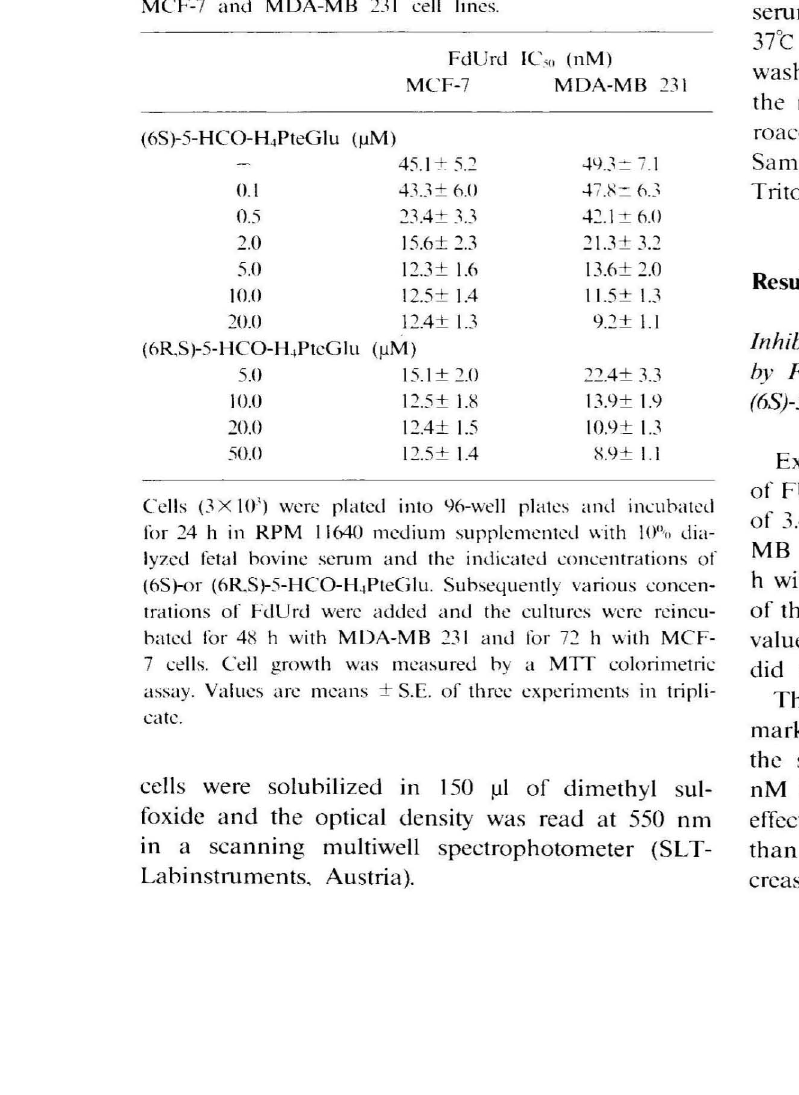
Table 1. Etlcct of increasing concentrations of (6S)- and (6R$)-S-HCO-H4PteGlu on the cytotoxicity of FdUrd in MCF-7 and MDA-MB 231 cell lines.